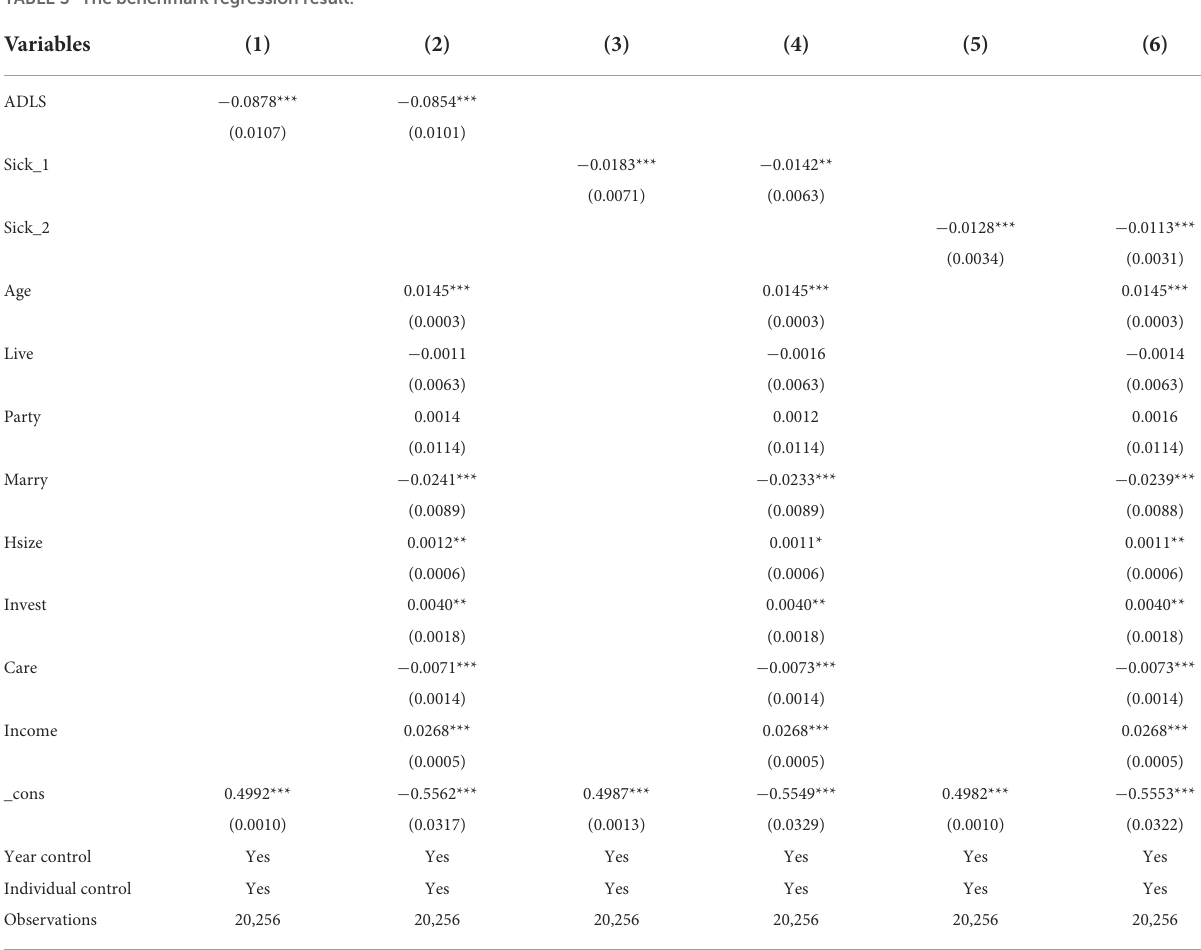
TABLE 3 The benchmark regression result.